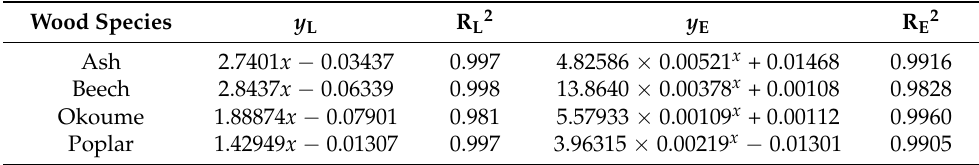
Table 3. Linear and exponential fit equations for initial and fracture evolution